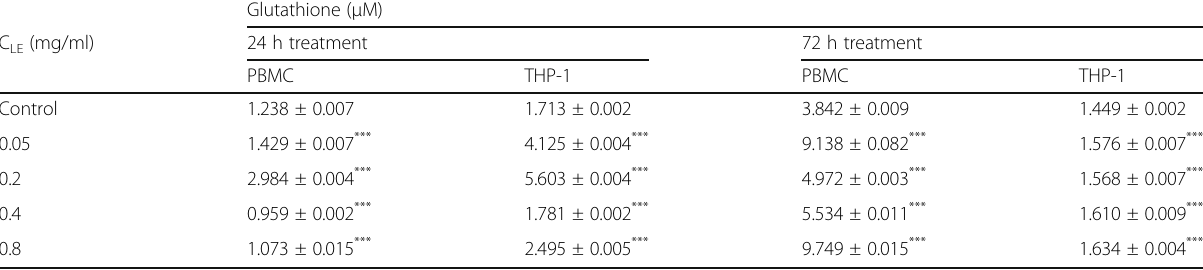
Table 1 Glutathione levels in C LE treated PBMC ’ s and THP-1 cells Glutathione ( μ